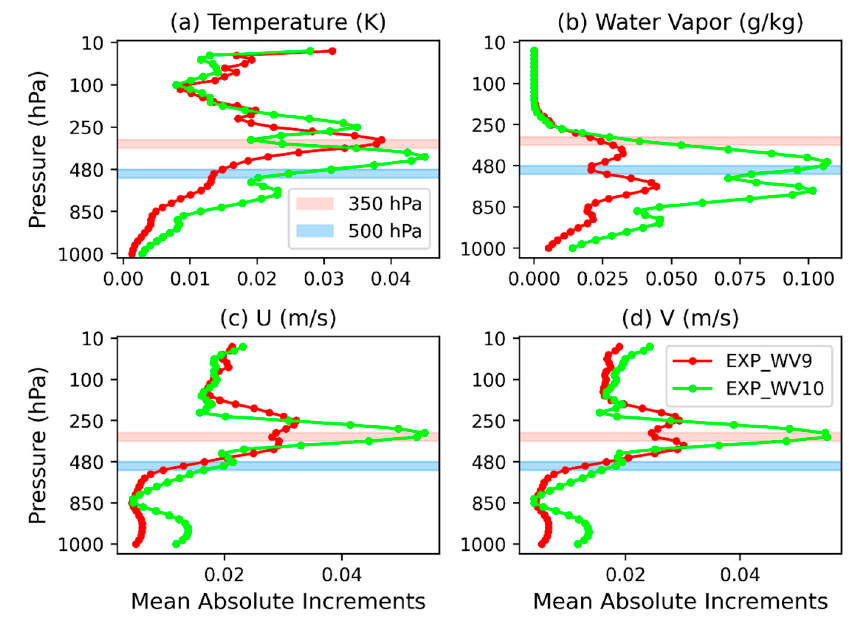
Figure 10. The vertical profiles of the domain averaged absolute increments for the ( a ) temperature, ( b ) water vapor, ( c ) U, and ( d ) V of the EXP_WV9 (red) and EXP_WV10 (light green) versus the CTL at 0000 UTC on 5 July 2020. The salmon and dodger-blue bars stand for 300 and 500 hPa, respectively.